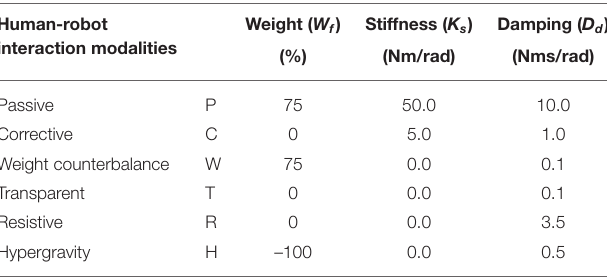
TABLE 1 | The proposed parameters used with the unified compliant controller to render the selected high-level human-robot interaction modalities. Human-robot interaction